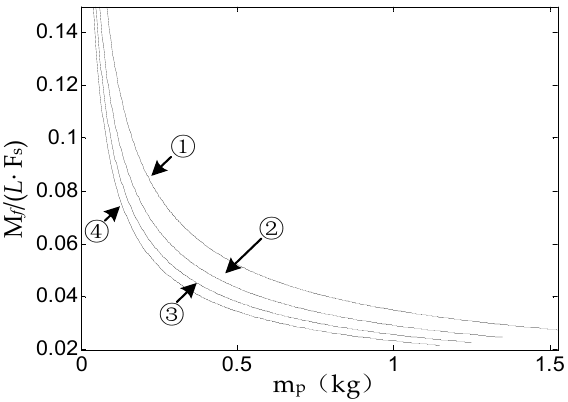
Figure 9. Changing curve of the ratio of M f / ( L · F s ) following m p .